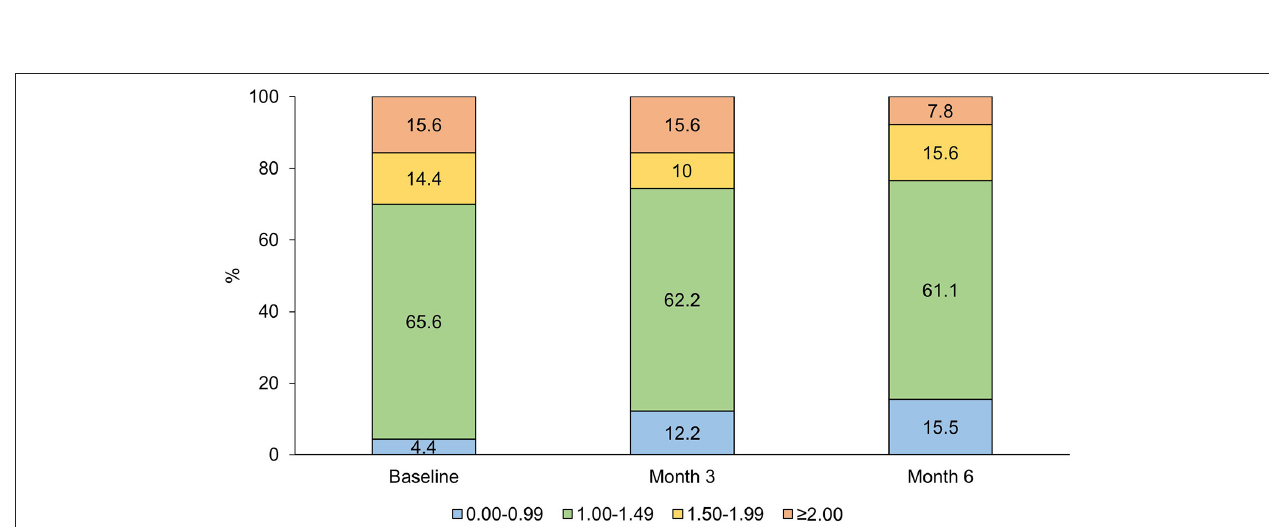
Frontiers in Neurology | www.frontiersin.org 5 February 2022 | Volume 13 | Article